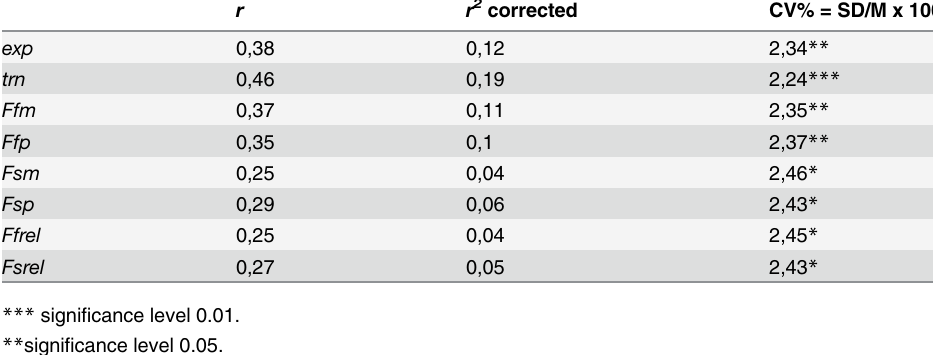
Table 2): Regarding the profile of the participants: Age, weight, height, BMI, experience in years, training hours per week and performance (mean value over 60 shots); regarding the strength of the participants: Peak finger flexor force, mean finger flexor force, peak finger flexor Table 3. Linear regression between performance and exp (experience), trn (training), Ffm (mean fin- ger flexor force), Ffp (peak finger flexor force), Fsm (mean isometric shoulder abduction force), Fsp (peak isometric shoulder abduction force), Ffrel (peak finger flexor force relative to the BMI) and Fsrel (peak isometric shoulder abduction force relative to the